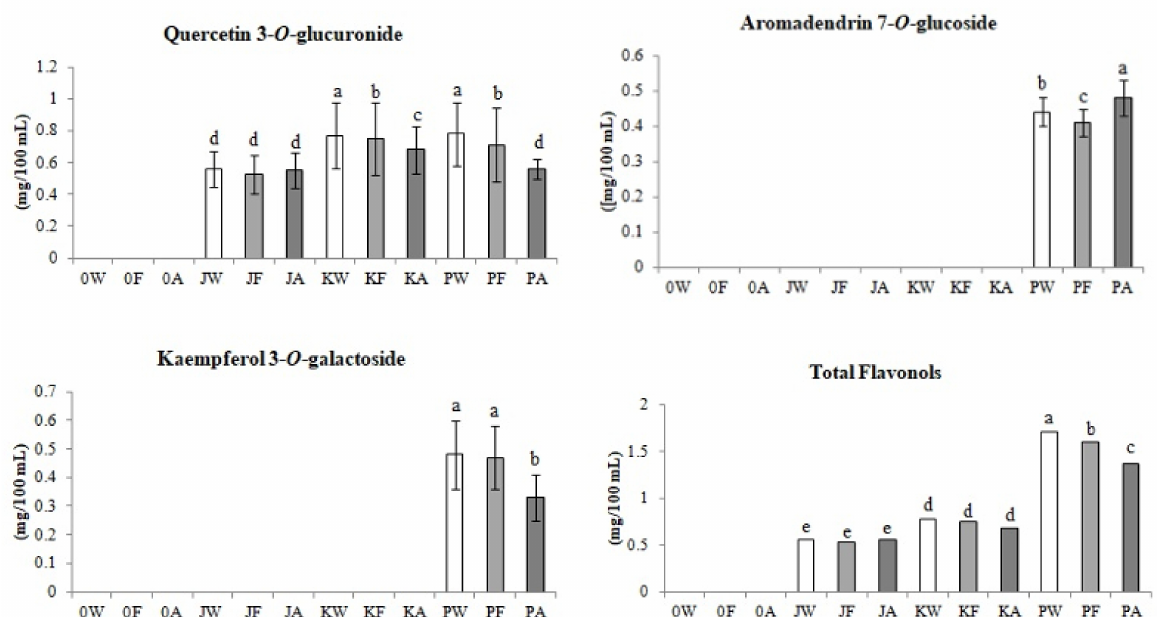
Figure 3. Changes in flavonols content (mg/100 mL) during control and fruit meads production technology. White bars—worts (W), light gray bars—samples after fermentation (F), dark gray bars—meads after aging (A). Sample codes: 0—control, J—samples with ‘Jantarnyi’ juice, K—samples with ‘Koralowyi’ juice, P—samples with ‘Podolski’ juice. Mean values with different letters: a, b, c, d, e are statistically different ( p <